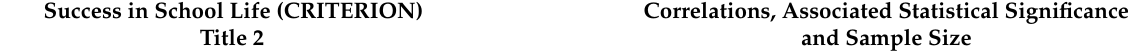
Table 1. Correlation matrix of the criterion variable with all the regressors or predictors considered. Source: own